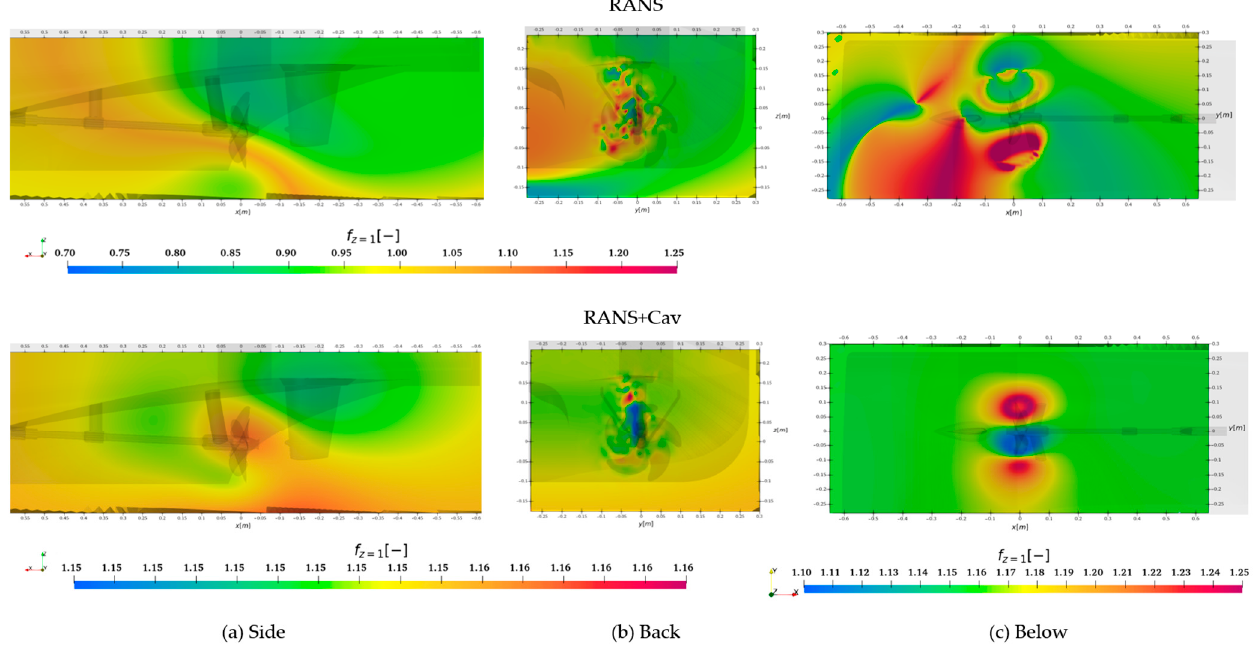
Figure 29. Complex phase angle information at f Z = 1 on the passive rectangular box shown in Figure